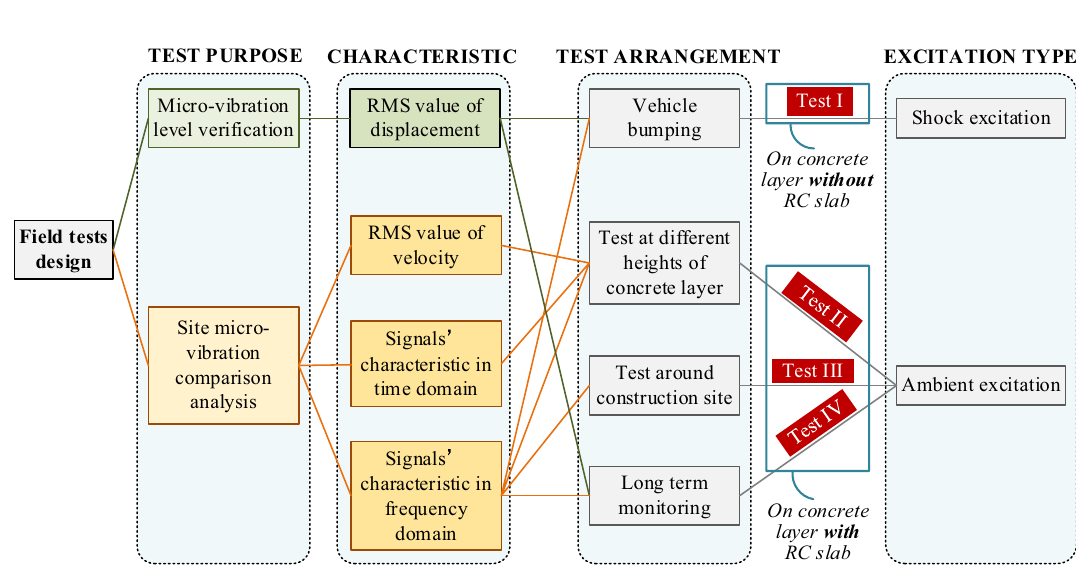
Figure 3. Field test